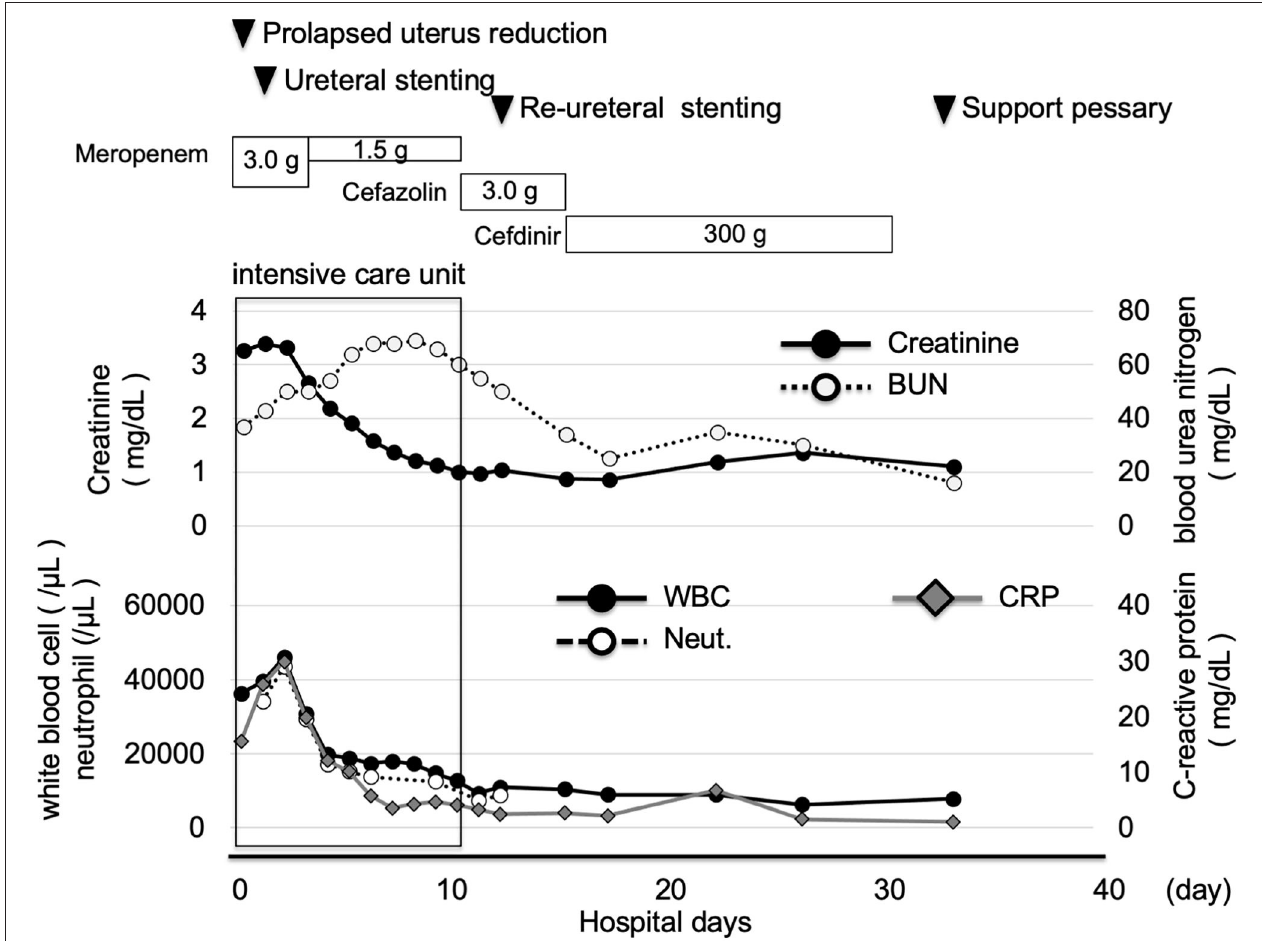
FIGURE 3 | Time course of clinical parameters in this subject. After prolapsed uterus reduction, ureteral stenting and starting antibiotics, her inflammation markers were markedly improved. She was transferred from intensive care unit to general ward at day 10. After then, her renal function and inflammatory markers were gradually normalized and she was finally discharged about 1 month after